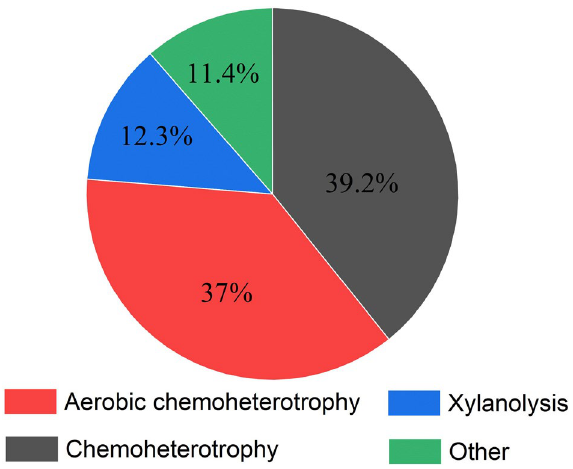
Figure 8. FAPROTAX abundance of thermophilic bacteria in aerobic composting.